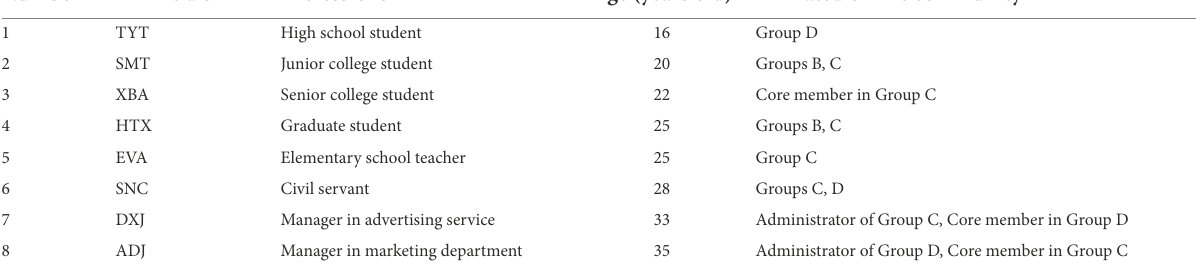
TABLE 2 Information of the eight fans selected for follow-up